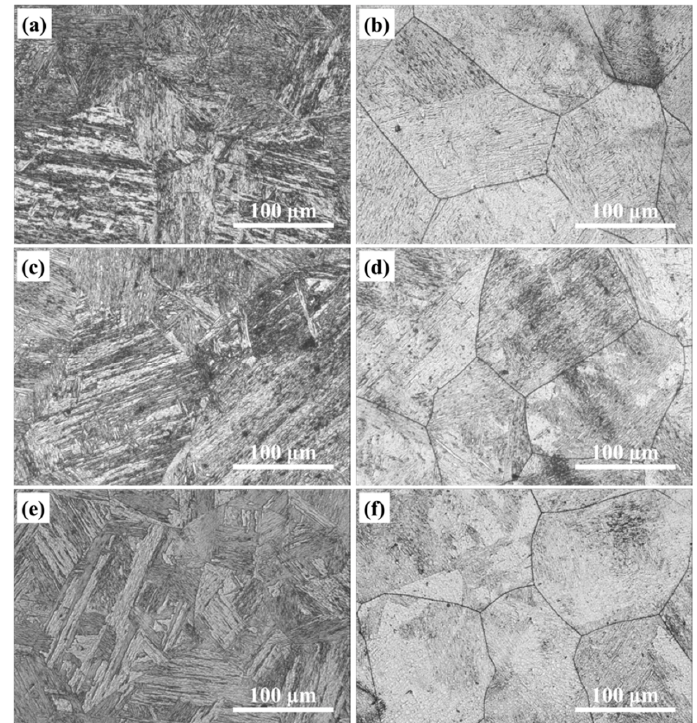
Figure 4. Optical micrographs of the specimens heated at 1300 °C for 180 s, furnace ‐ cooled to 750 °C and held there for 1 h, followed by water quenching: ( a ) and ( b ) unadded steel; ( c ) and ( d ) P ‐ added 750 ◦ C and held there for 1 h, followed by water quenching: ( a , b ) unadded steel; ( c , d ) P-added steel; ( e ) and ( f ) P+Ce ‐ added steel; ( a ), ( c ), and ( e ) etched with nital; ( b ), ( d ), and ( f ) etched with steel; ( e , f ) P + Ce-added steel; ( a , c , e ) etched with nital; ( b , d , f ) etched with supersaturated picric acid supersaturated picric acid aqueous solution. aqueous